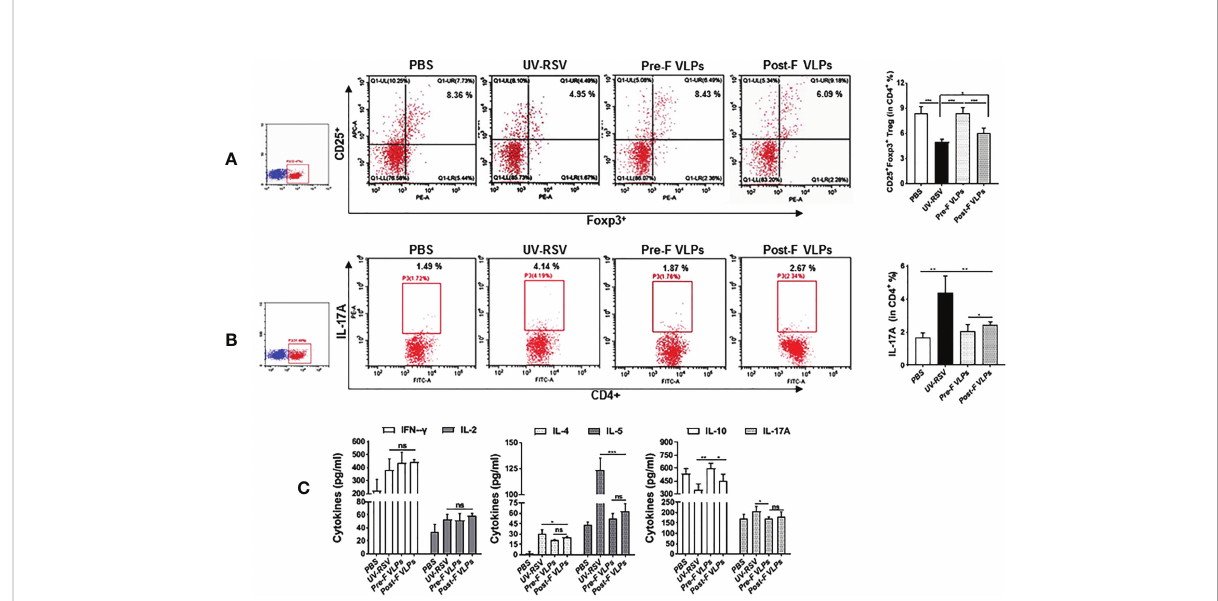
FIGURE 5 Cellular immune responses in the lungs of vaccinated mice induced by RSV challenge infection. Mice were immunized i.m. thrice and challenged i.n. with RSV 2 weeks after the fi nal immunization. Lungs were harvested on Day 4 p.c. The percentage of CD25 + Foxp3 + Treg cells (A) or IL-17A (B) in CD4 + T cells from the lungs was measured by fl ow cytometry with speci fi c antibody staining. (C) Th1 cytokine (IFN- g & IL-2), Th2 cytokine (IL-4 & IL-5) and the cytokines IL-10 and IL-17A concentrations were measured by ELISA. Data are presented as mean values ± SDs for six mice in each group. Pairwise comparisons of values were performed using one-way ANOVA or Student ’ s t test followed by the Tukey test. *** P < 0.001; ** P < 0.01; * P < 0.05; ns, not signi fi cant.